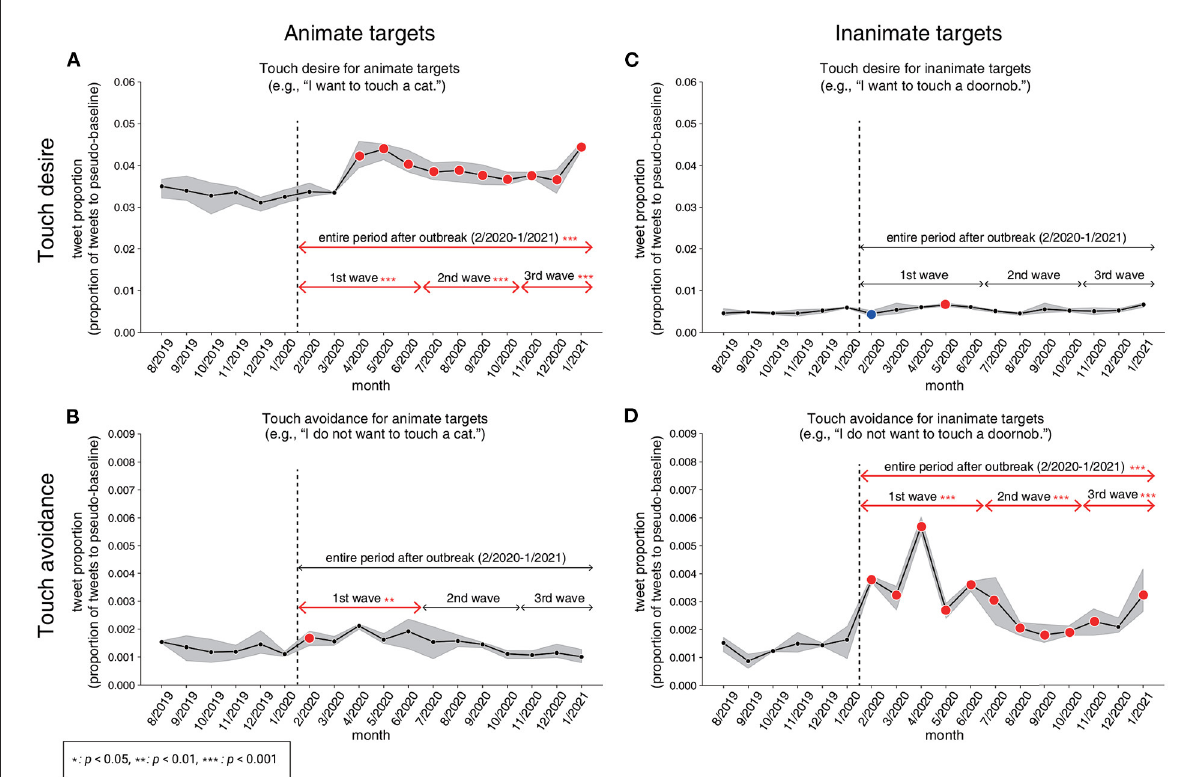
FIGURE3 Changes in tweet proportion and the results of the DID and the event study. Results on touch desire (A) and touch avoidance (B) for animate targets. Results on touch desire (C) and touch avoidance (D) for inanimate targets. Lines represent the tweet proportion (the proportion of tweets relative to the pseudo-baseline) with shaded areas showing the 95% Confidence Interval (CI). The vertical dashed line indicates the timing of the outbreak. In addition, the effects of the entire period after the COVID-19 outbreak and the 1st–3rd waves are indicated (full results are presented in Supplementary Table 1). Red-colored arrows represent that the tweet proportion increased significantly during those periods. Blue-colored arrows represent that the tweet proportion decreased significantly during those periods. Also, red-colored and blue-colored points denote the results of the event study analysis. Red-colored points represent that the difference in tweet proportion between the focused month after the COVID-19 outbreak and the other 6 months just before the COVID-19 outbreak increased significantly relative to those in past years (2013–2018). Blue-colored points represent that the difference in tweet proportion between the focused month after the COVID-19 outbreak and the other 6 months just before the COVID-19 outbreak decreased significantly relative to those in past years (2013–2018). The decrease and increase in the tweet proportions were not significant in any month in the period before the COVID-19 outbreak, which supports the assumption for the parallel